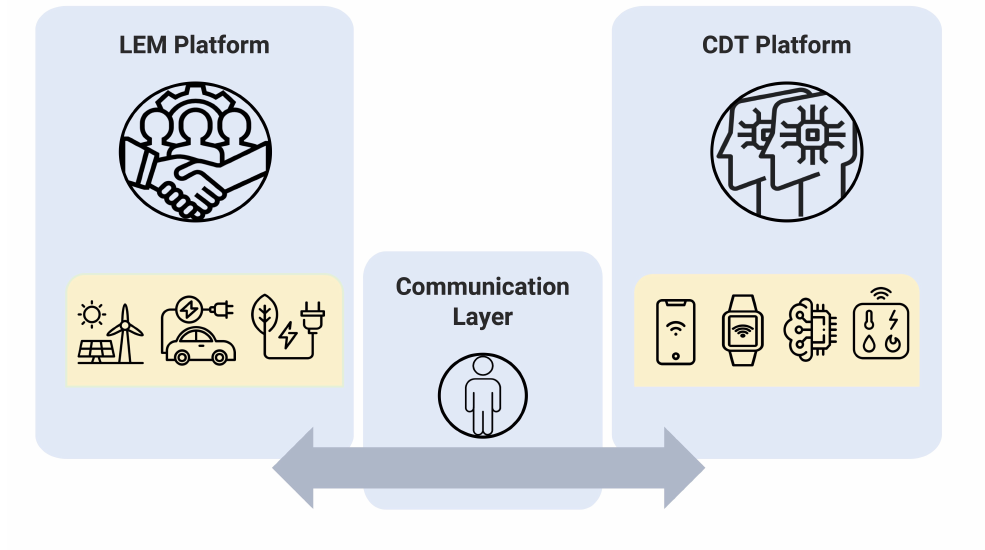
Figure 5. Integration of LEM and